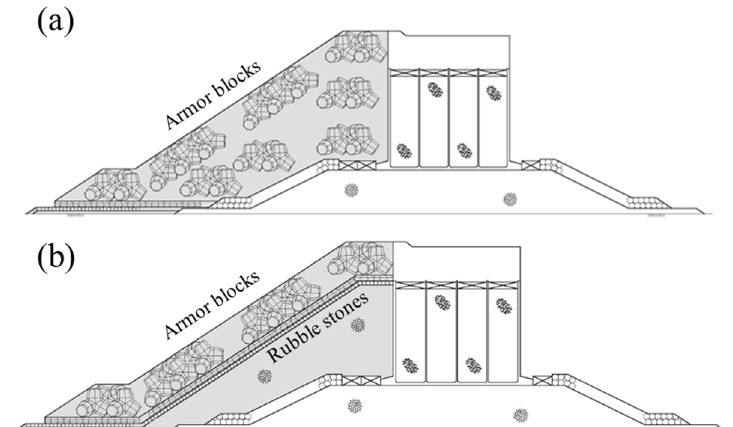
Figure 1. Conceptual diagrams of a horizontally composite breakwater whose front face is covered with ( a ) only armor blocks and ( b ) armor blocks on the rubble-mounted core.